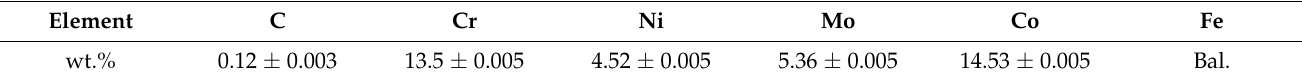
Table 1. Chemical composition of the